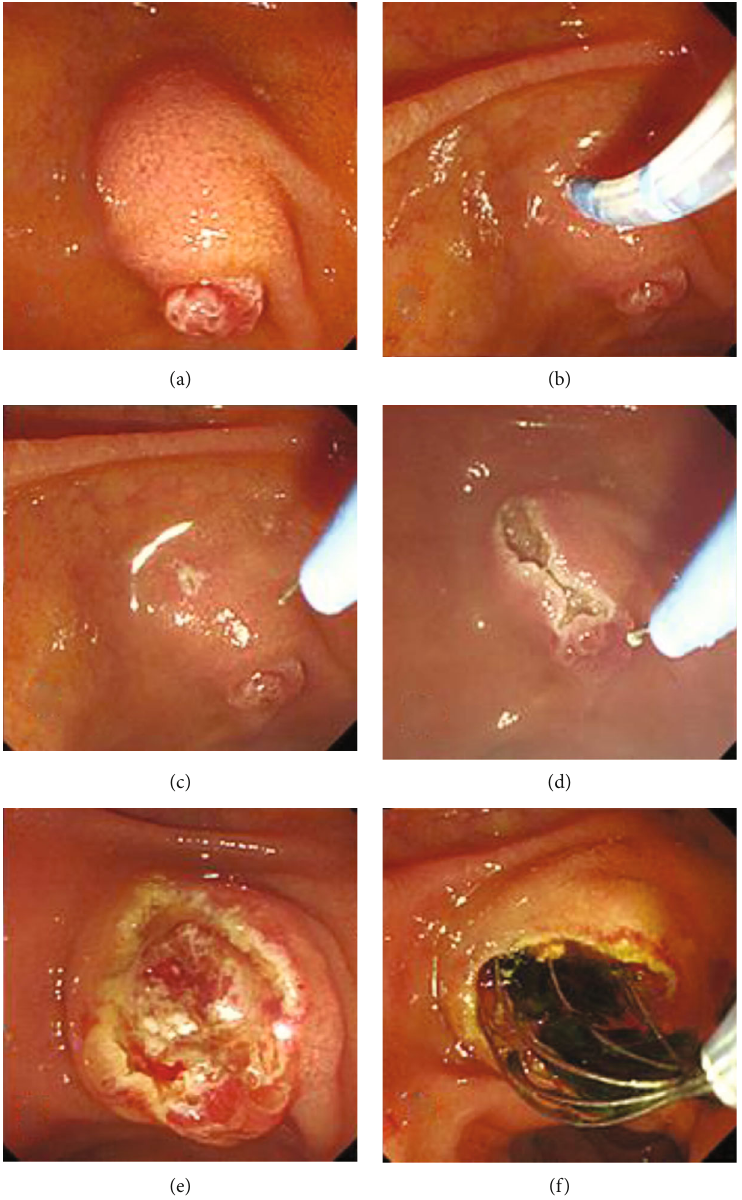
Figure 1: Needle-knife sphincterotomy procedure. (a) The major duodenal papilla is reached with a duodenoscope. (b) The needle-knife sphincterotome is introduced to perform an incision on the infundibulum. (c) The needle tip is advanced about 3-4 mm from the sheath and moved toward the bulging portion of the common bile duct. (d) The precut incision is formed from the top of infundibulum to the papilla ori fi ce in a downward direction. (e) The pinkish mucosa of the bile duct is visualized after the incision. (f) The CBD stones are removed successfully using a basket without expanding the